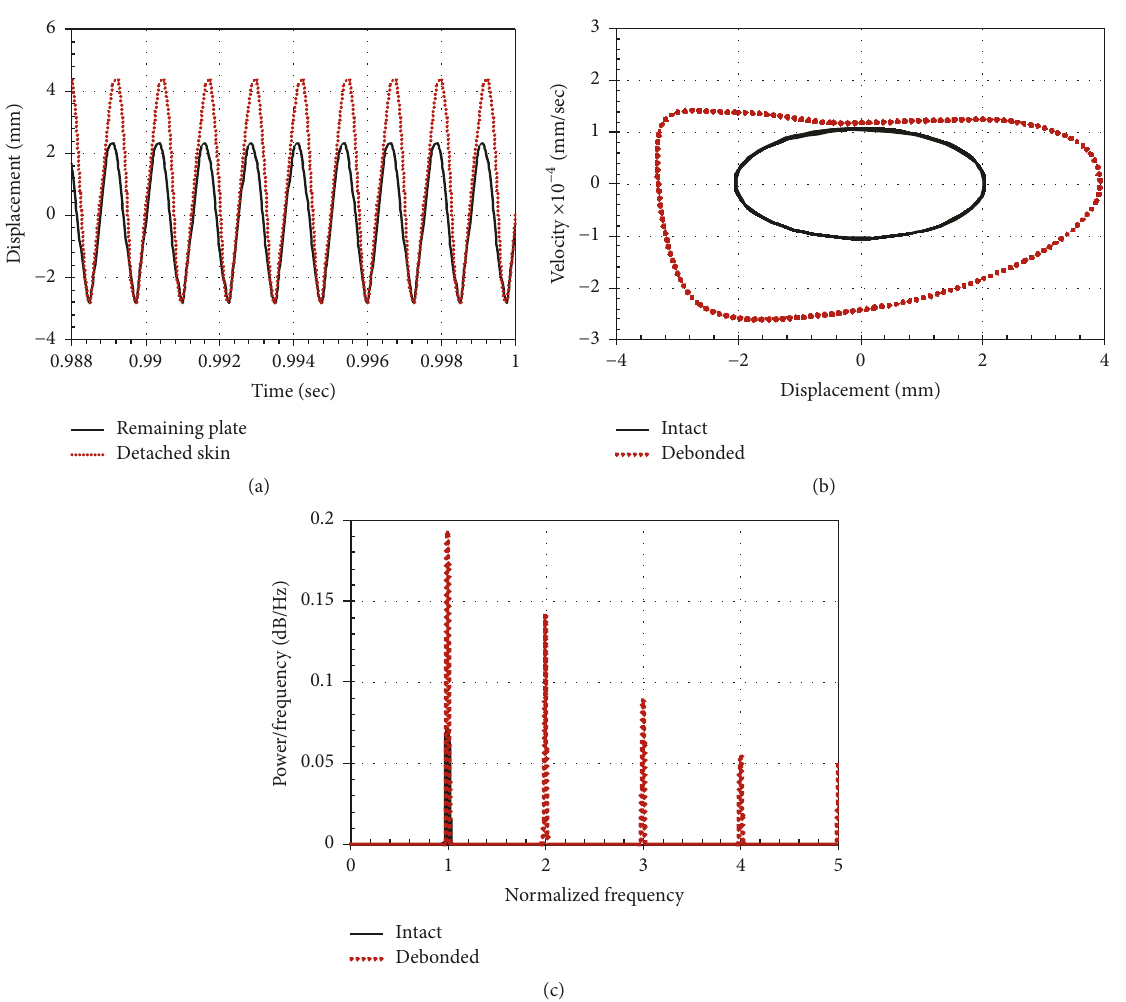
Figure 23: Steady-state dynamic response at 𝜂 = 3/4 (Ω = 800 Hz ) [80]: (a) displacement time histories at points N2 and N3; (b) phase portrait at point N1; and (c) frequency spectra of the displacement signals at point